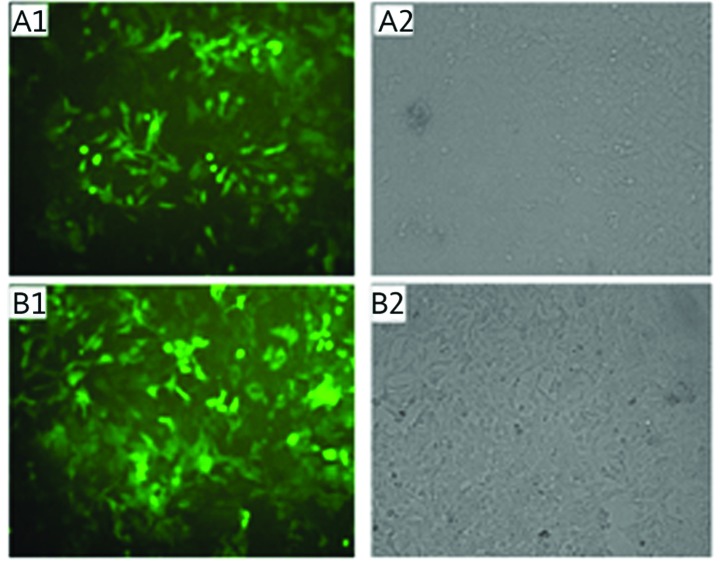
Assessment of transfection efficiency in SKOV3 cells transfected with recombinant plasmid (magnification, ×20). (A1 and 2) Fluorescent and transmitted light images of SKOV3 cells transfected with pGPU6-cyclooxygenase-2-shRNA recombinant plasmid. (B1 and 2) Fluorescent and transmitted light images of SKOV3 cells transfected with pGPU6-Control-shRNA recombinant plasmid. sh, small hairpin.